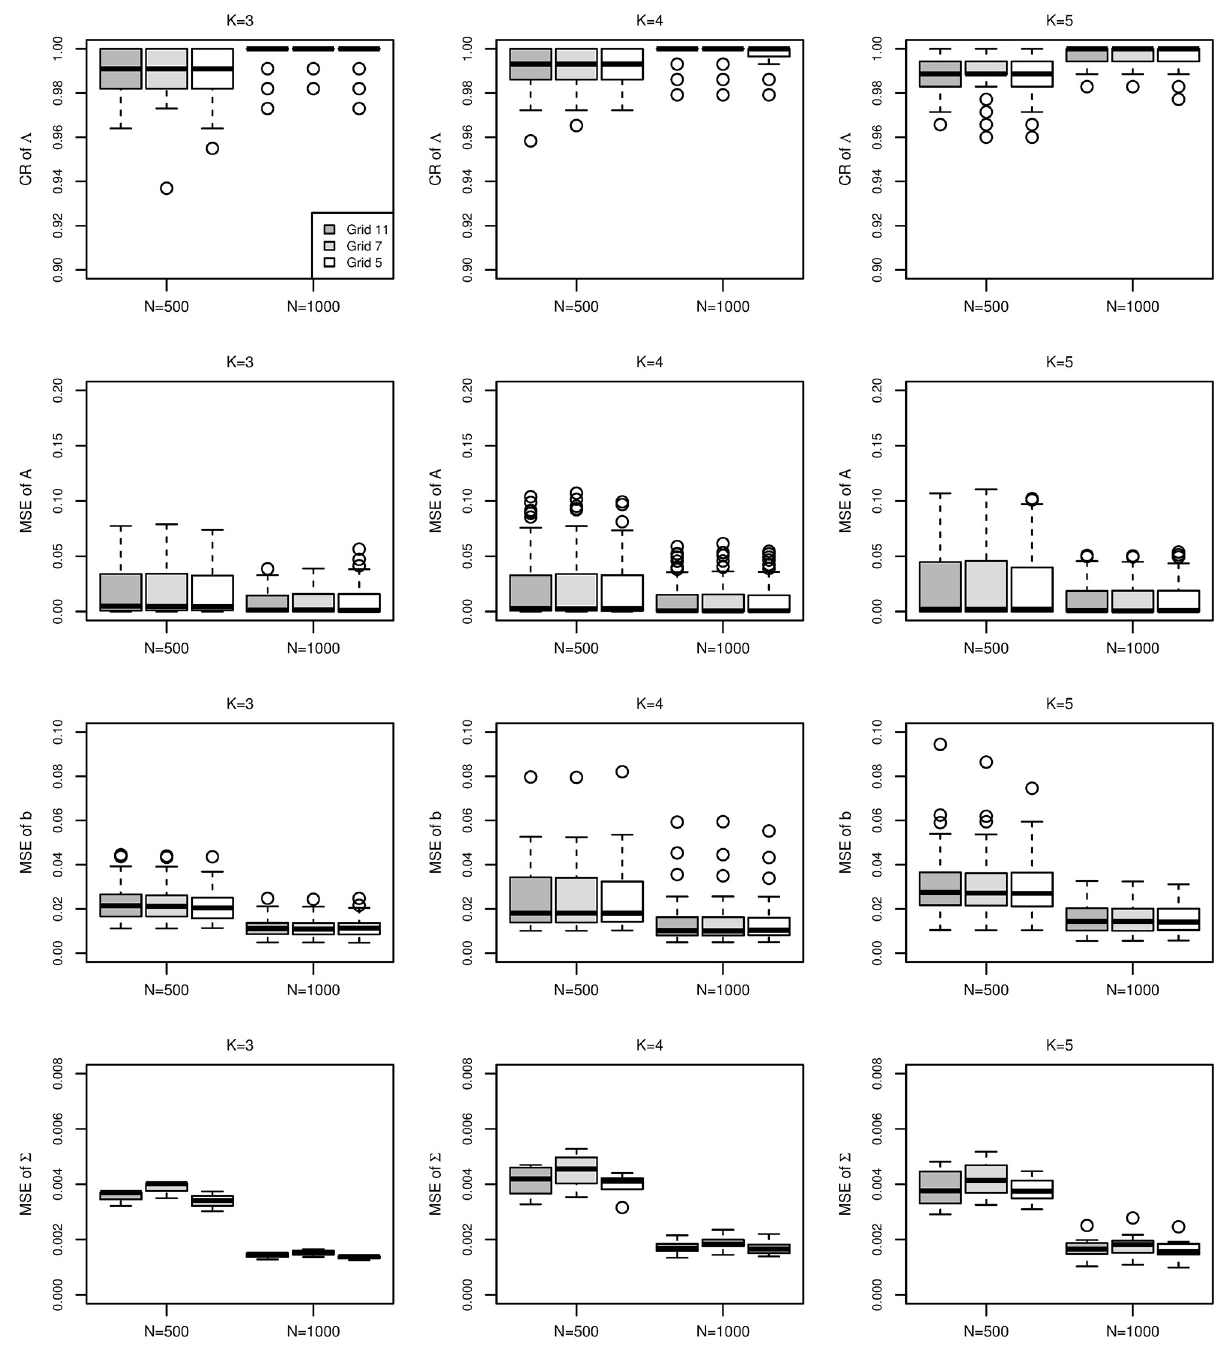
Fig 7. Boxplots of the correct rate of Λ (row 1), the MSE of A (row 2), the MSE of b (row 3) and the MSE of Σ (row 4) for K = 3 (column1), 4 (column 2) and 5 (column3) under sample size N = 500 and 1000. The dark gray boxes, light gray boxes and white boxes represent the results via 11, 7 and 5 grid points per